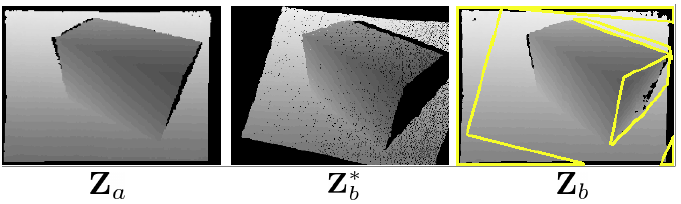
Figure 5. An intuitive example of the prediction process. The depth image Z ∗ from Z a as the image captured by sensor b virtually. The uncorrelated information in Z b is outlined with yellow lines.